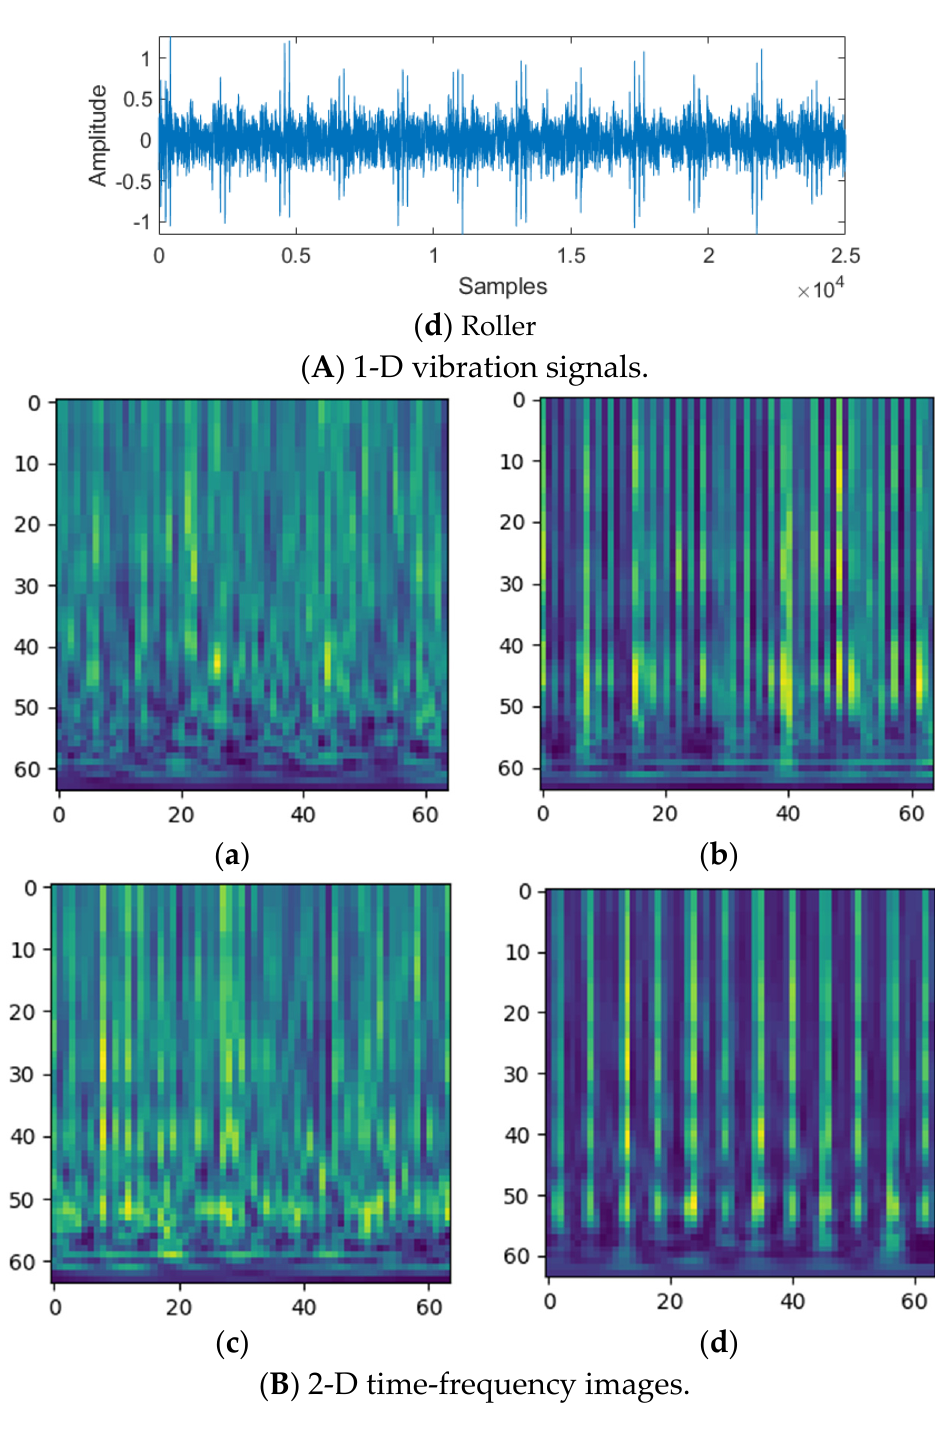
Figure 8. 1 − D vibration signals and 2 − D time–frequency images for vibration signals: ( a ) normal, ( b ) inner race fault, ( c ) outer race fault, and ( d ) roller race fault.